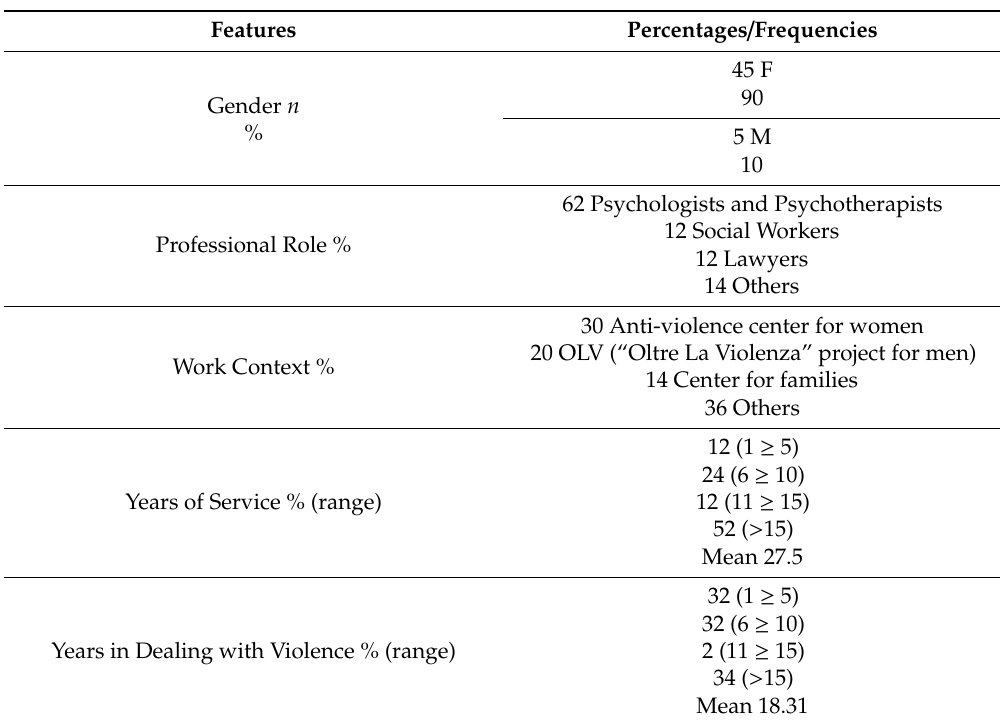
Table 1. Participants’ data. This table illustrates some information about